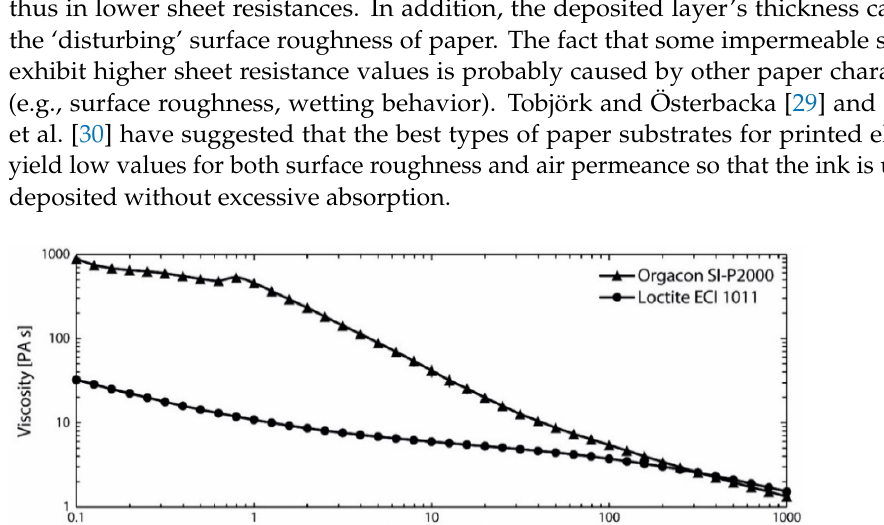
9 of 20 Figure 6. Sheet Resistance as function of Air Permeance of ‘Orgacon SI-P2000 ′ ( ▲ , A ) and ‘Loctite ECI 1011 ′ square prints ( ● , B ). Green symbols indicate the 13 paper samples that were selected for further investigation.